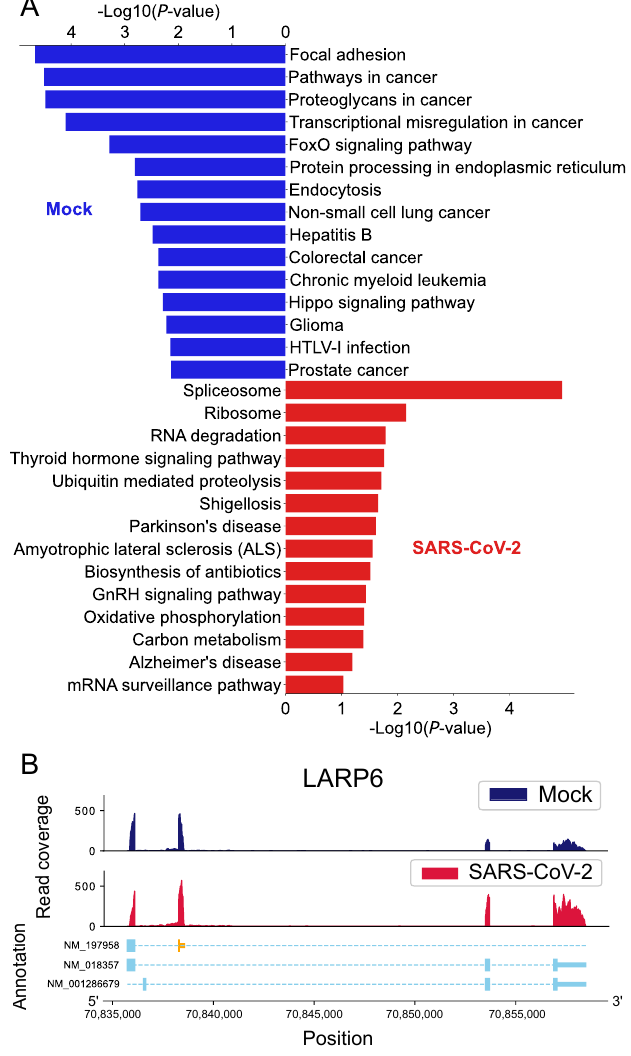
Figure 5. ( A ) KEGG pathways enriched by CR-APA events. The blue and red bar charts show the pathways enriched by the APA events in mock-treated cells and SARS-CoV-2 infected cells, respectively. ( B ) One example of a gene ( LARP6 ) shows an alternative polyadenylation event in the coding region. The truncated coding exon is highlighted in orange.